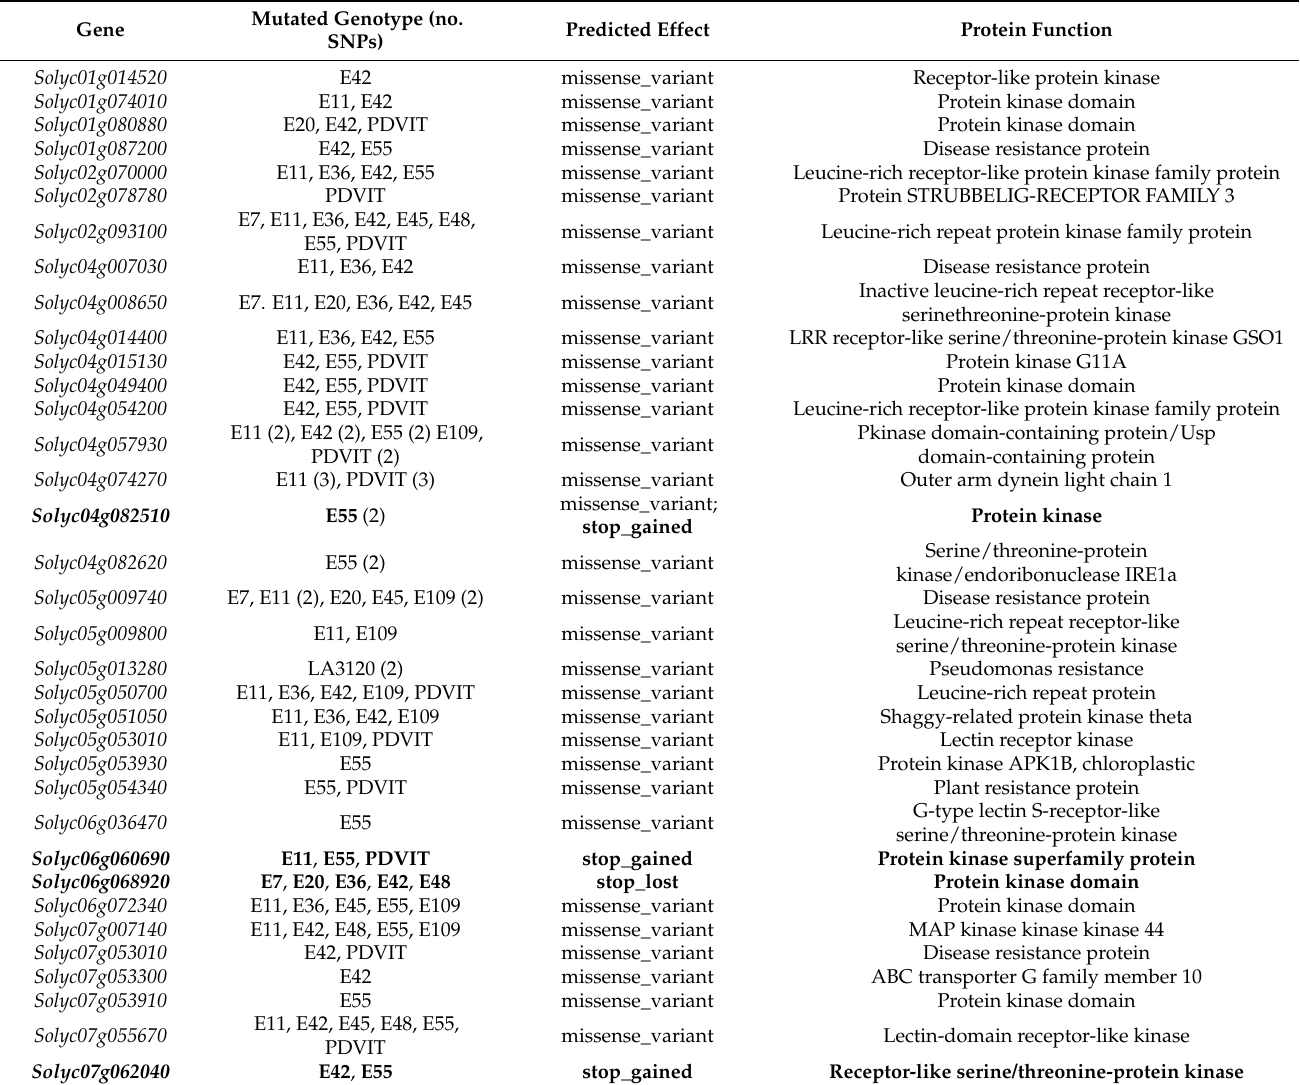
Table 1. List of 71 SNPs with high (in bold) and moderate impact detected in 57 resistance genes reported in the PRG database (prgdb.org; accessed on 2 September 2021). The locus and the protein function were reported together with the genotypes carrying each mutated gene respect to the reference genome Heinz1706 (www.solgenomics.net; accessed on 2 September 2021). When more than one SNP was detected in the same gene for some genotypes, the number of SNPs is reported in